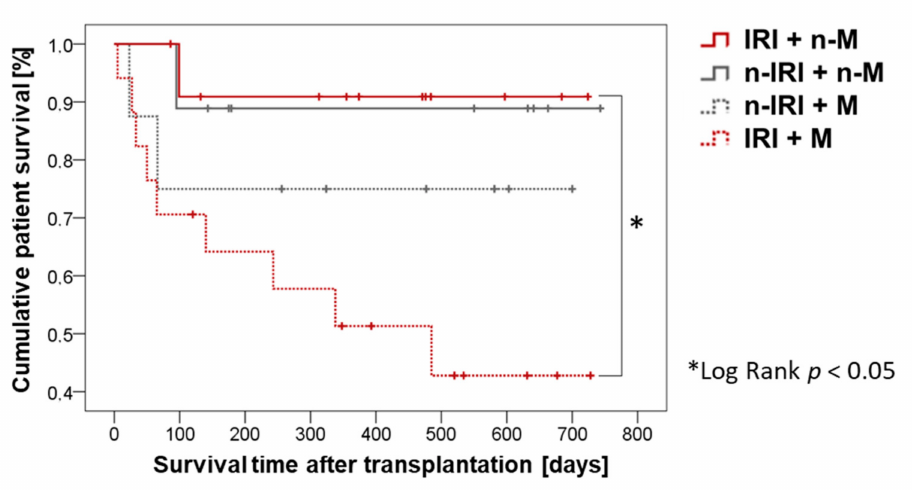
Figure 1. Cumulative patient survival compared to patients with existing or absent histo-pathological IRI and marginal and non-marginal